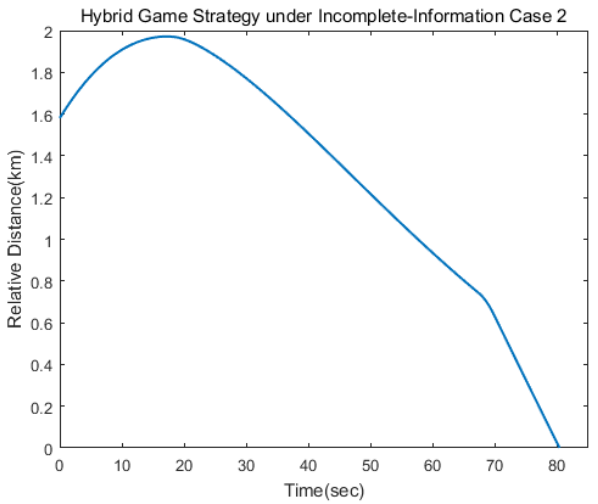
Figure 11. Relative distance between the pursuer and the target.